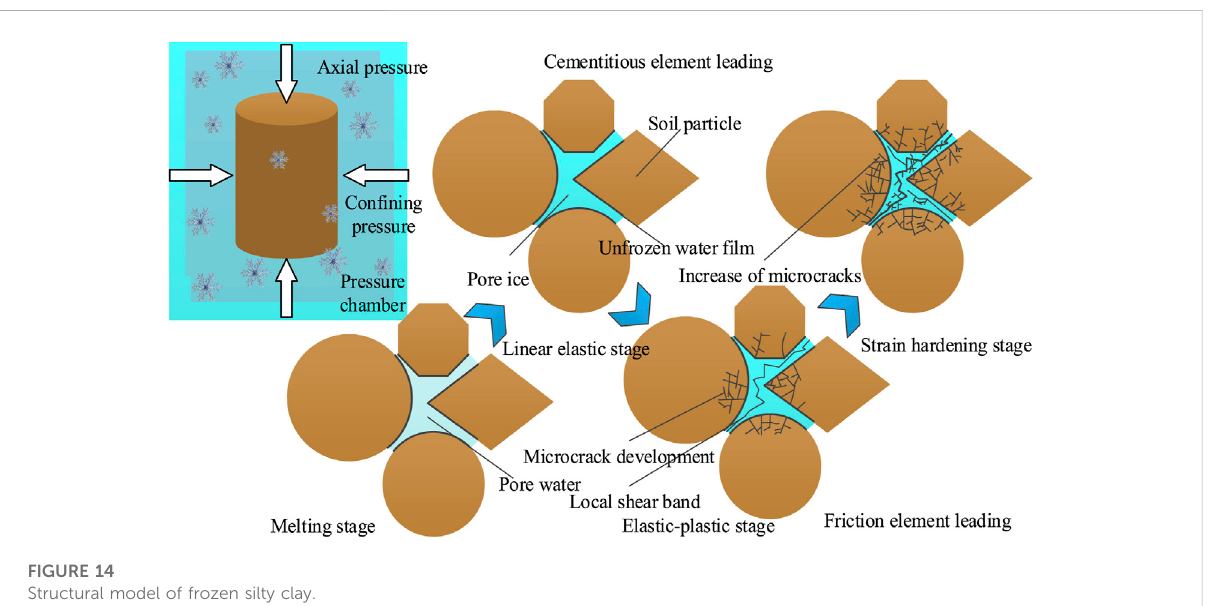
FIGURE 14 Structural model of frozen silty